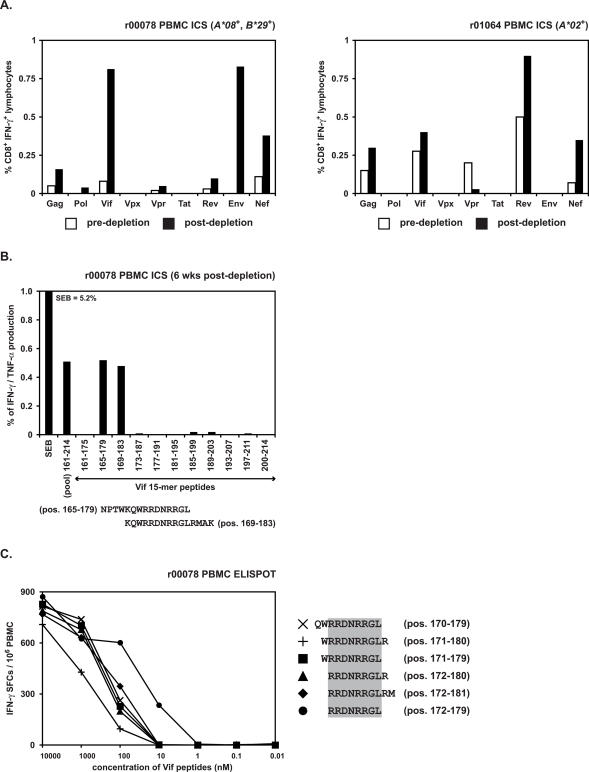
Identification and mapping of a novel CD8+ response directed against Vif that expanded in two CD8+ cell-depleted EC macaques, r00078 and r01064.MHC class I alleles detected by PCR-SSP are listed for each animal. A) Unknown CD8+ responses from ex vivo ICS assays using SIV peptide pools performed one month prior to (white bars) and four weeks after (black bars) CD8+ cell depletion. Responses to 15-mer pools that did not contain previously identified minimal optimal epitope sequences [64], [73], [82] are summed for each protein. Of particular interest was an unknown SIV-specific CD8+ response directed against Vif, which expanded in two Mamu-B*17-negative ECs r00078 and r01064. B) Ex vivo ICS deconvolution of peptide pool Vif E (positions 161–214) using r00078 PBMC demonstrated that the novel CD8+ epitope was located within two overlapping 15-mers in Vif (positions 165–183). C) Ex vivo IFN-γ ELISPOT using peptide dilutions in r00078 fine-mapped the novel CD8+ epitope to an 8-mer at positions 172–179 in Vif (RRDNRRGL). Mean values from triplicate wells were calculated for each peptide test.